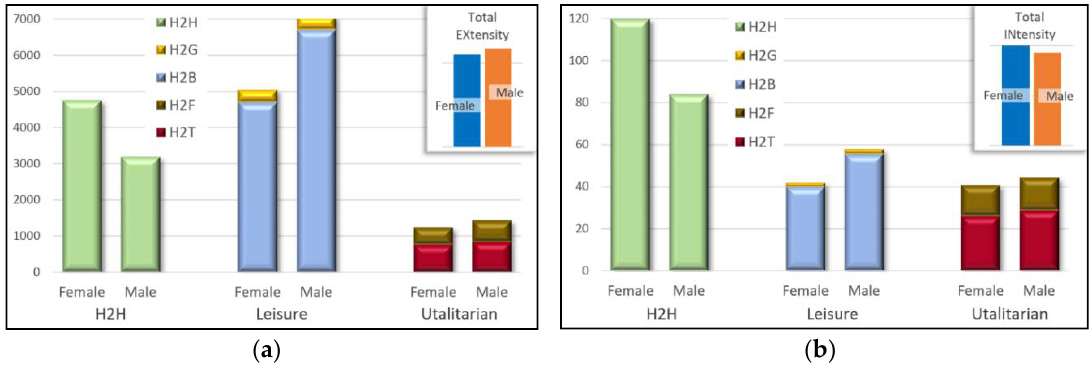
Figure 5. Gender as fixed factor and six covariates; MANCOVA estimated marginal means of communication type per user per day: ( a ) extensity; ( b ) intensity.